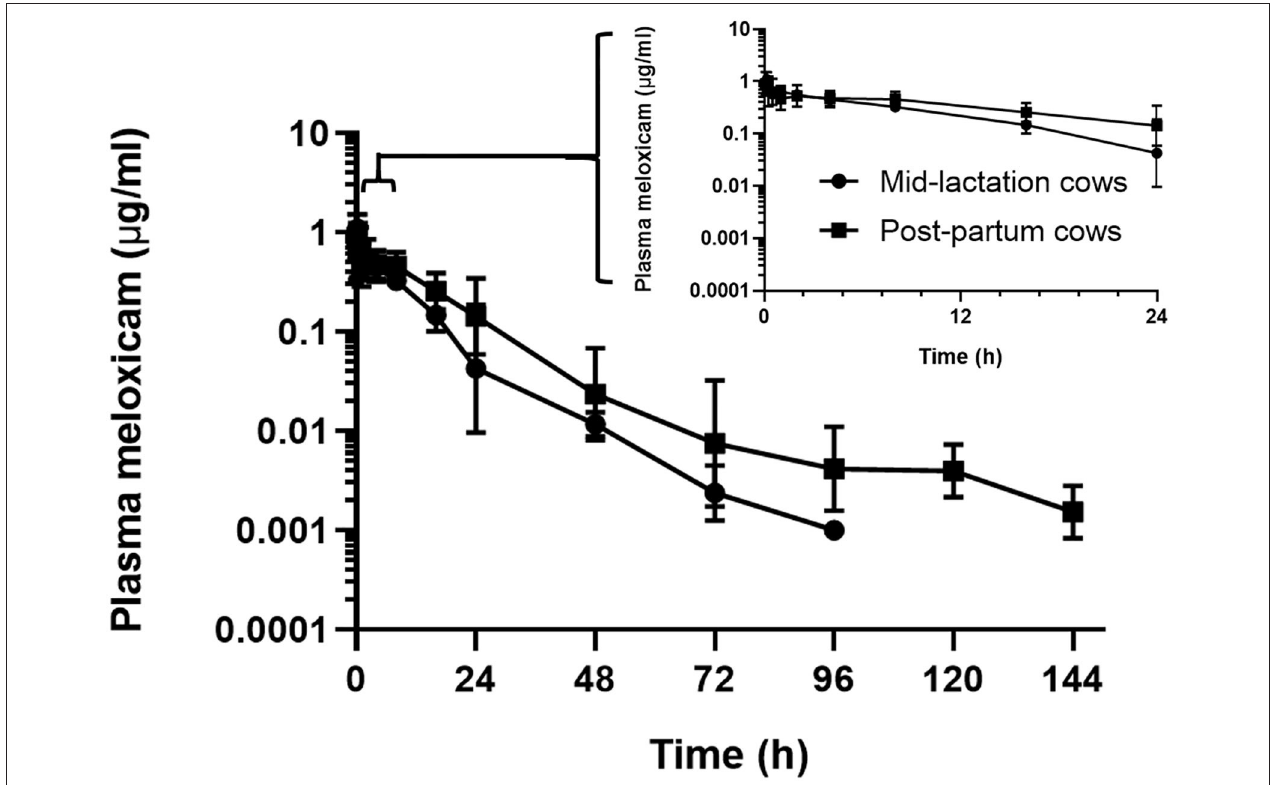
FIGURE 1 | Semilogarithmic transformation of geometric mean plasma concentration (with 95% confidence interval) for post-partum ( n = 7) and mid-lactation ( n = 5) cows that received a single dose of intravenous meloxicam at 0.2 mg/kg. Inset contains first 24h after meloxicam administration.